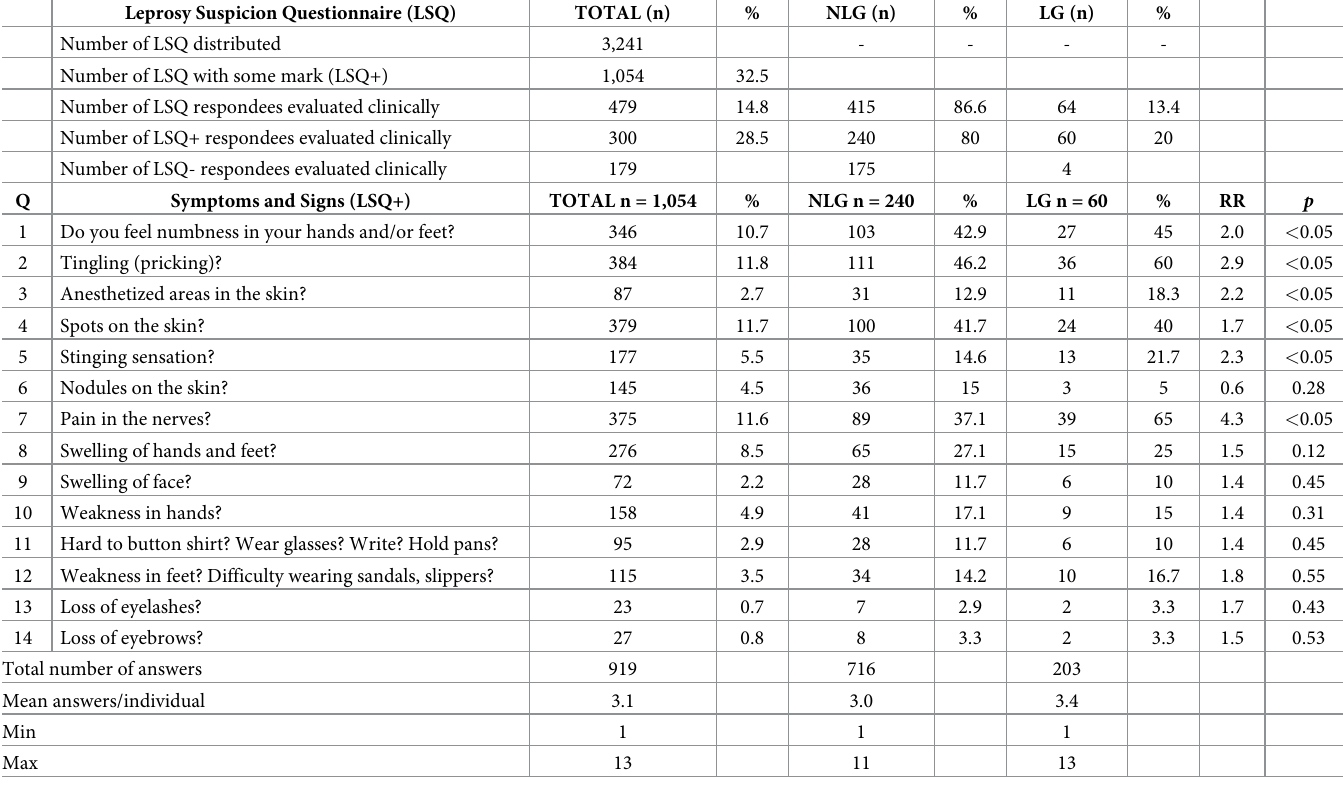
Table 1. Number of individuals ranked according to total signs and symptoms of leprosy marked on the LSQ in order of frequency (n = 1,054). Leprosy Suspicion Questionnaire